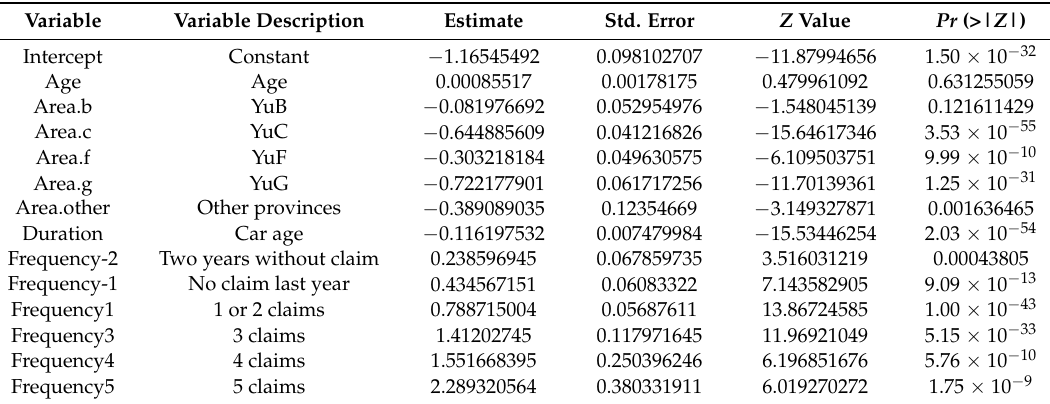
Table 7. The Logistic regression regardless of the auto burden